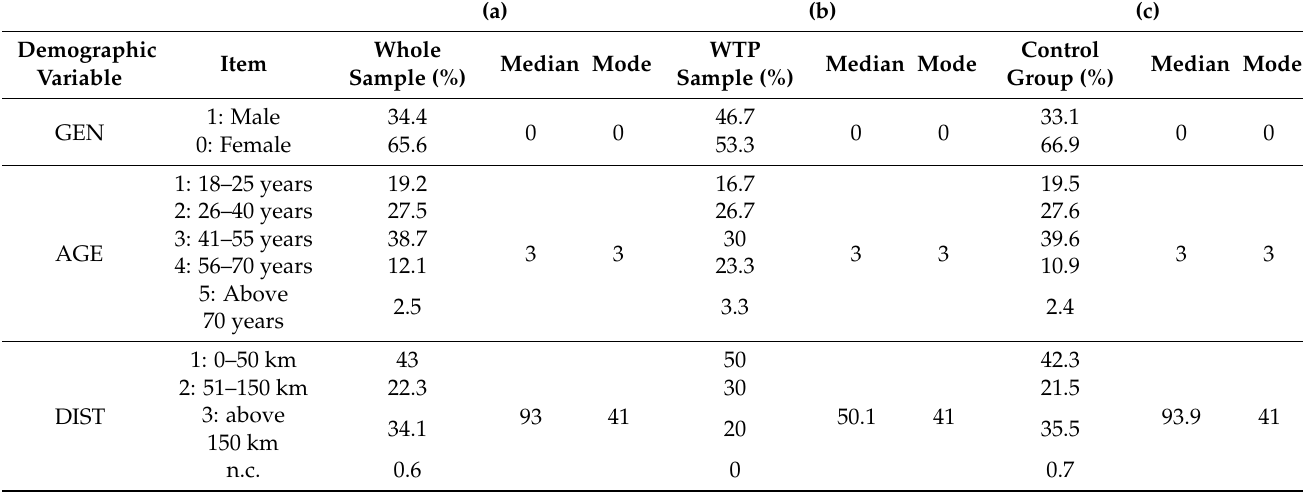
Table 2. Characteristics of